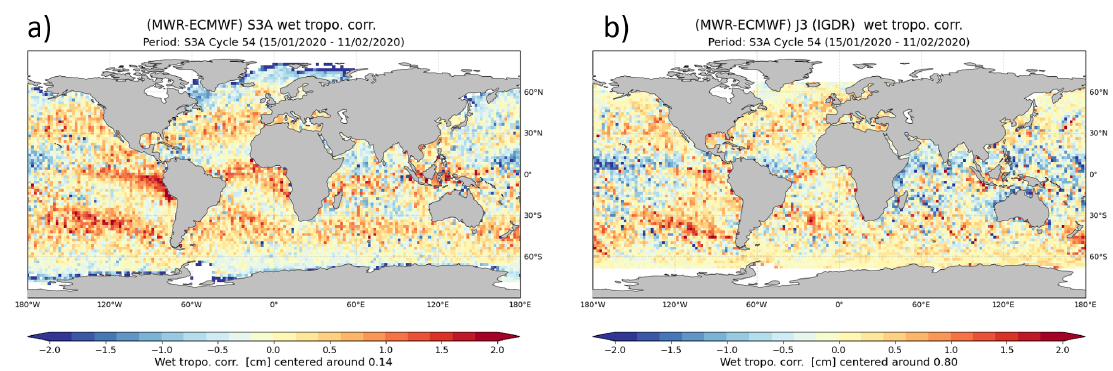
Figure 14. Geographical variation of WTC bias (MWR-derived correction minus those from ECMWF model. ( a ) S3A, with a mean bias of 0.14 cm removed ( b ) Jason-3 MWR for the same period, with 0.80 cm